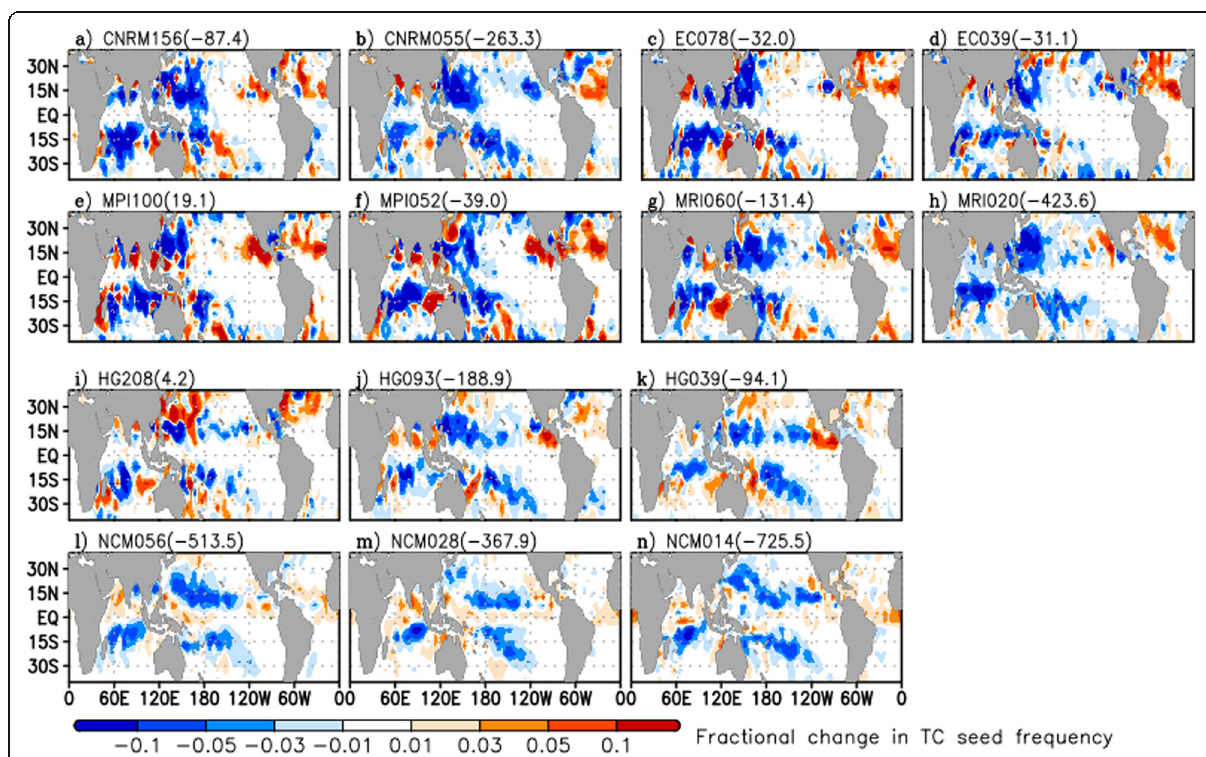
Fig. 5 Horizontal distributions of future change in TC seed existence density. Existence density was defined as the number of TC seeds per year existed in a 5°×5° grid box. Future change was defined as a difference between 25-year mean values of TC genesis density in the future climate (2025 – 2049) and the present-day climate (1990 – 2014). Red colors indicate an increase in TC seed existence density due to global warming. Blue colors indicate a decrease in TC seed existence density. Panels show future changes in TC seed existence density of HighResMIP models: a CNRM156, b CNRM055, c EC078, d EC039, e MPI100, f MPI052, g MRI060, h MRI020, i NICAM056, and j NICAM028. The numbers in parentheses are changes in the global annual TC seed frequency for each